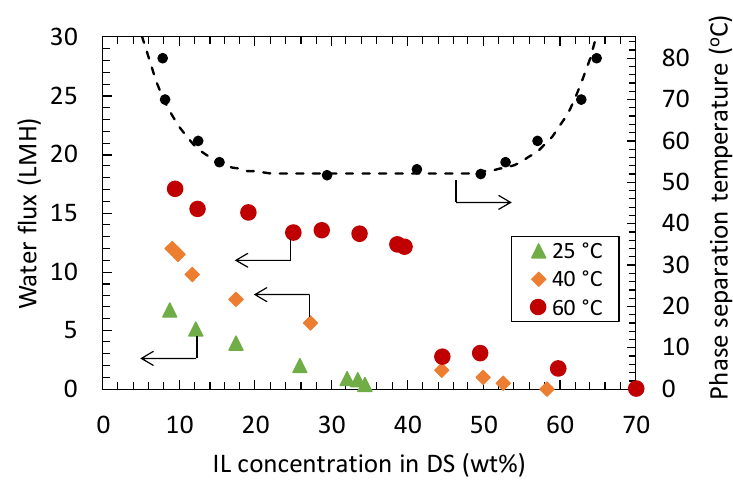
Figure 5. Relationship between the water flux and [N 4444 ][TMBS] concentration in DS at different temperatures. The black plot with broken lines is the phase diagram of the [N 4444 ][TMBS] aqueous solution.